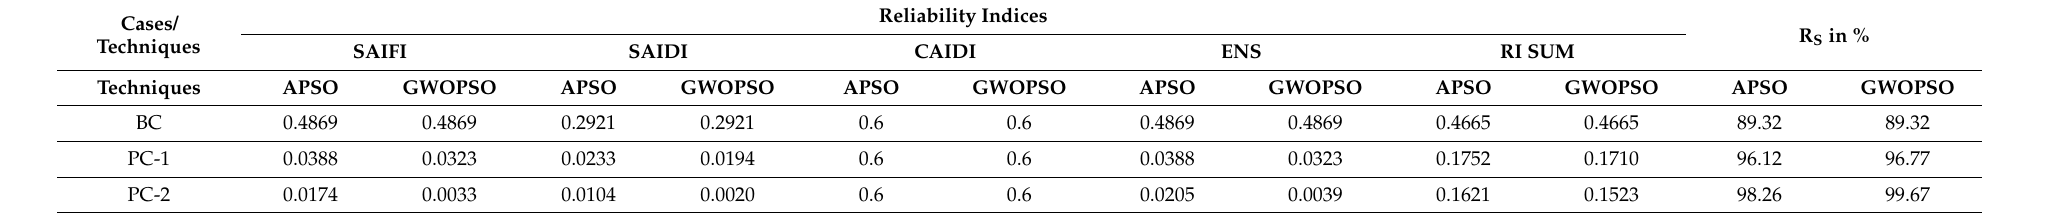
Table 7. Indices of Reliability of the IEEE 33 bus RDN.